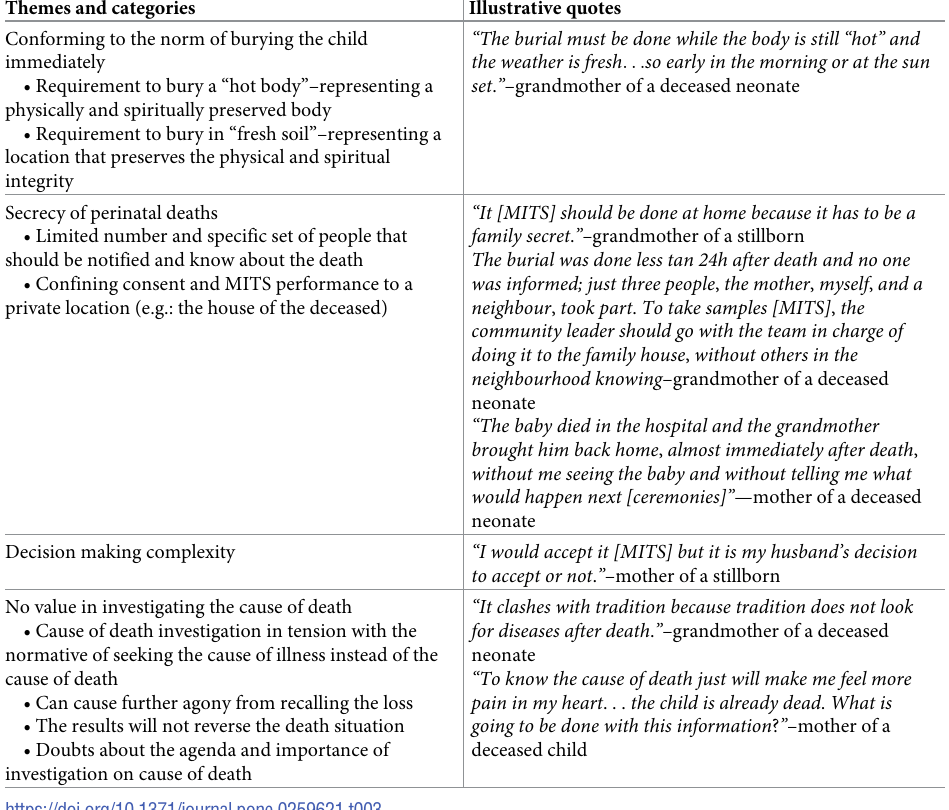
Table 3. Parents and guardians accounts on anticipated barriers to the performance of MITS on their deceased